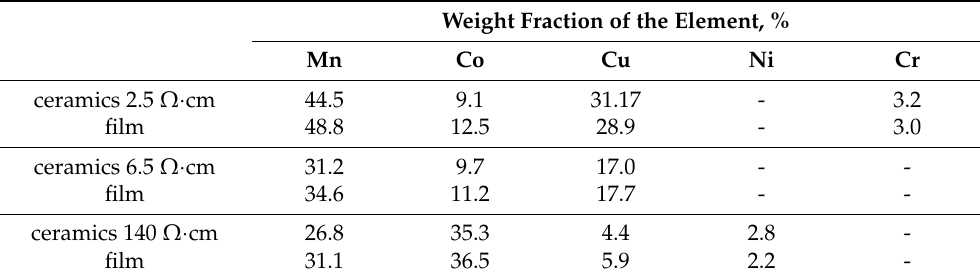
Table 1. Elemental composition of ceramic materials used for the manufacture of targets, as well as the composition of deposited films with a thickness of 1.5 μm . Weight Fraction of the Element, % Mn Co Cu